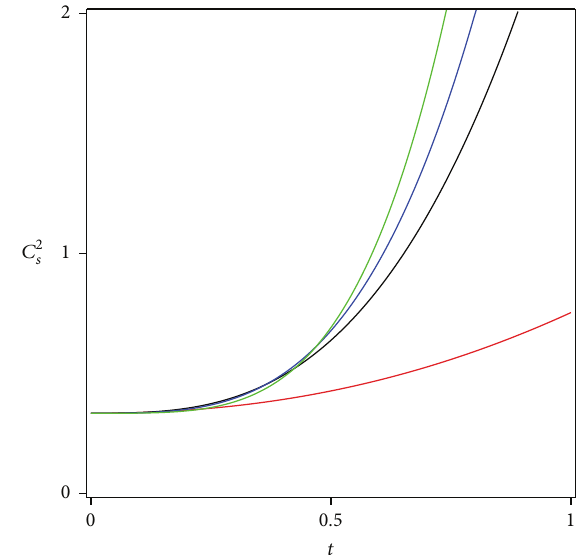
Figure 12: Time evolution of 𝛿 for 𝐵 = 3 , 𝐶 1 = 1 , 𝑛 = 1 , 𝐴 = 1/3 , and 𝛼 = 0.5 . 𝑘 = 0 (blue line), 𝑘 = 5 (red line), 𝑘 = 10 (green line).